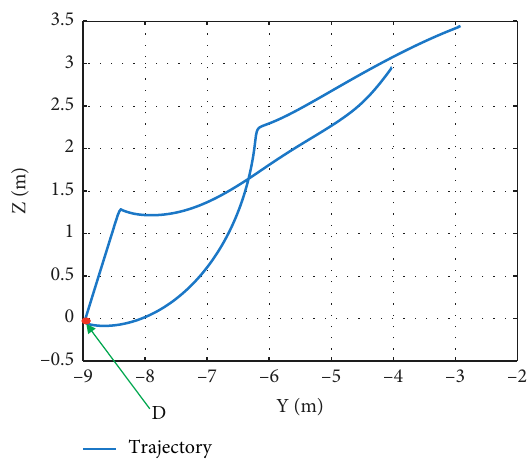
Figure 3: The shape of the trajectory in the working coordinate.